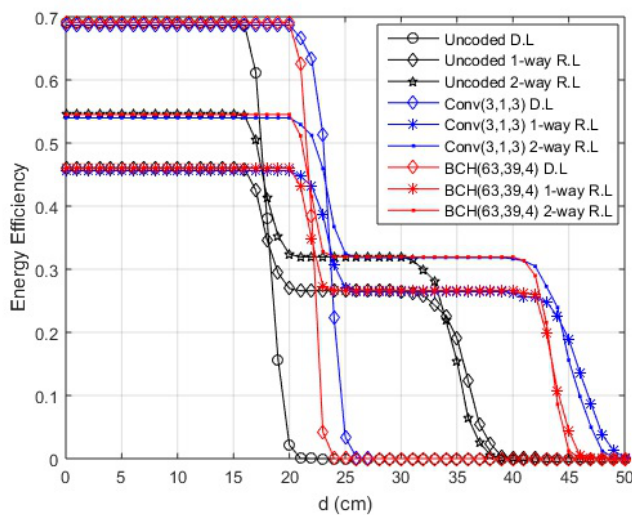
Figure 16. Energy efficiency for JNC coded data, convolutional R = 1/3, BCH t = 4 (in-body communication).